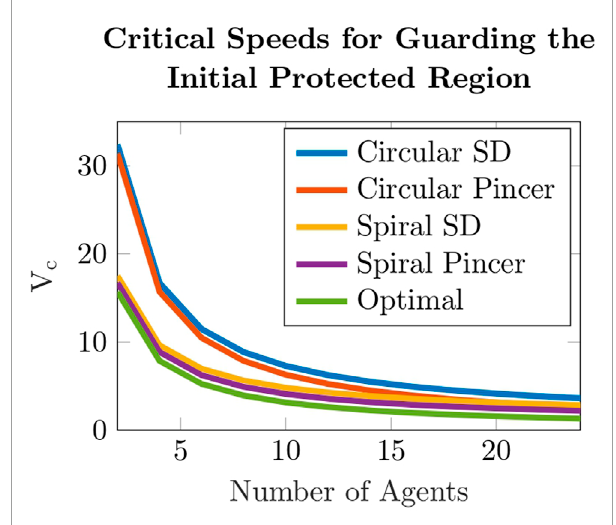
FIGURE 7 Critical speeds as a function of the number of defenders. The number of defenders is even, and ranges from 2 to 24 defenders, that perform the spiral and circular defense pincer sweep protocols as well as the spiral and circular defense same-direction sweep protocols. The optimal lower bound on the critical speeds is presented for comparison as well. The chosen values of the parameters are r = 10, V T = 1 and R 0 =